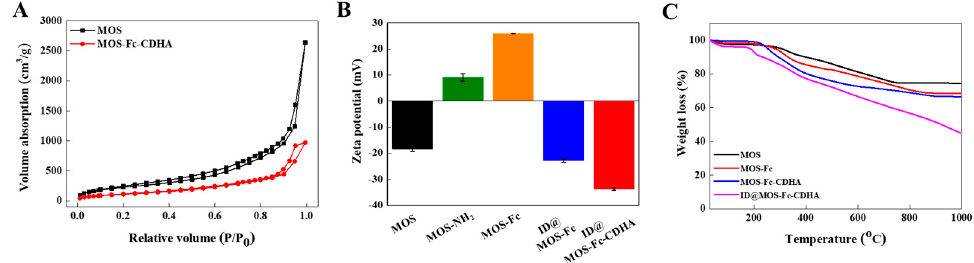
Figure 2. Characterization of the ID@MOS-Fc-CDHA nanocomposites. ( A ) N 2 adsorption/desorption isotherm of the MOS and MOS-Fc-CDHA nanocomposites. ( B ) Zeta-potential of the MOS, MOS-NH 2 , MOS-Fc, ID@MOS-Fc, and ID@MOS-Fc-CDHA nanocomposites. ( C ) TGA analysis of the MOS, MOS-Fc, MOS-Fc-CDHA, and ID@MOS-Fc-CDHA nanocomposites. 3.2. Photothermal and Photodynamic Performances of the ID@MOS-Fc-CDHA Nanocomposites via the NIR Laser Irradiation